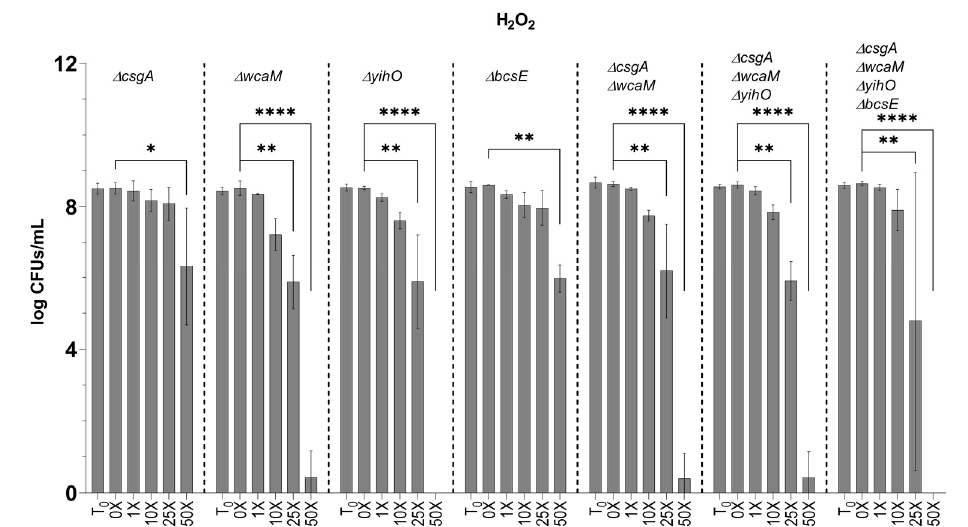
Figure 6. Tolerance of EPS mutants to H 2 O 2 . Biofilm aggregates deficient in one or more EPS(s) were challenged with H 2 O 2 at the same concentrations detailed above. S. Typhimurium Δ csgA Δ wcaM Δ yihO Δ bcsE data were used from Figure 5 for comparative purposes. Significance between CFUs determined by two-way ANOVA with Tukey multiple correction (*, P < 0.05; **, P <0.01; ****, P < 0.0001). Error bars indicate